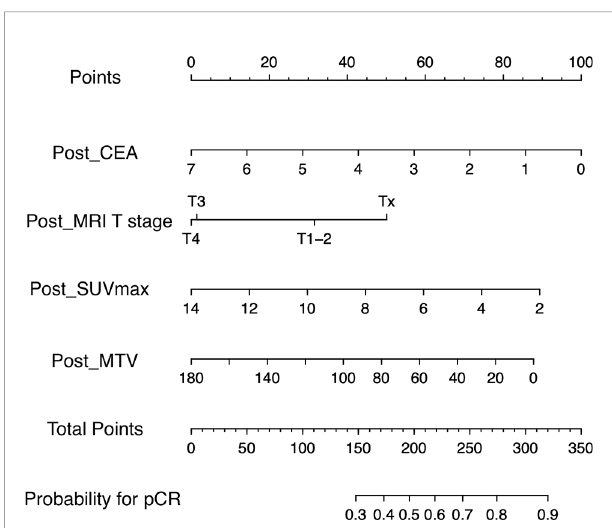
FIGURE 1 | Nomogram for predicting pathologic complete response. A point for each predictor can be read out along the top scale bar, ‘ Points ’ . The sum of points or total points is converted to the ‘ probability for pCR. pCR ’ (CEA, carcinoembryonic antigen; MRI, magnetic resonance imaging; SUVmax, maximum value of standardized uptake value; MTV, metabolic tumor volume; pCR, pathologic complete response).